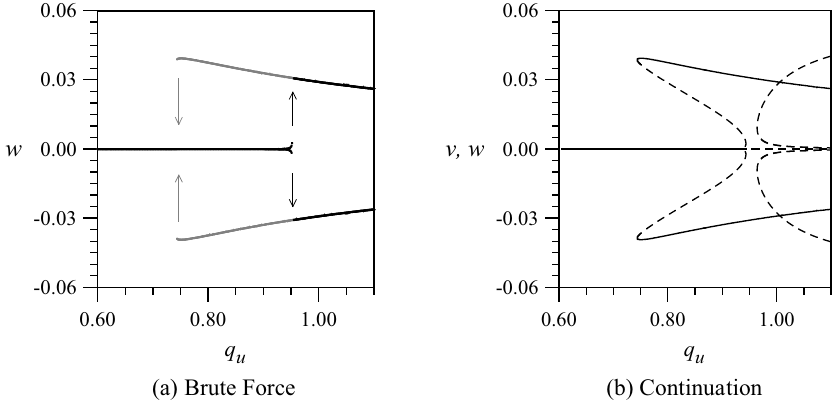
Fig. 9. Bifurcation diagram for the beam under harmonic axial forcing: q u cos(1.97 ω 0 t ) .